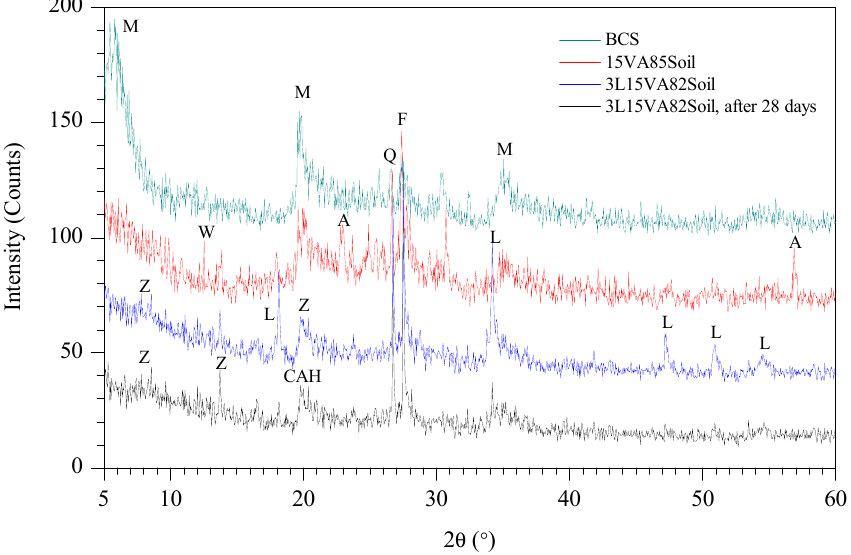
Figure 8. X-ray diffraction of unstabilized and stabilized BCS. (Annotations show M = montmorillonite, Q = quartz, F = feldspar, A = augite, Z = zeolite, W = wollastonite, L = lime, and CAH = calcium aluminate hydrate).